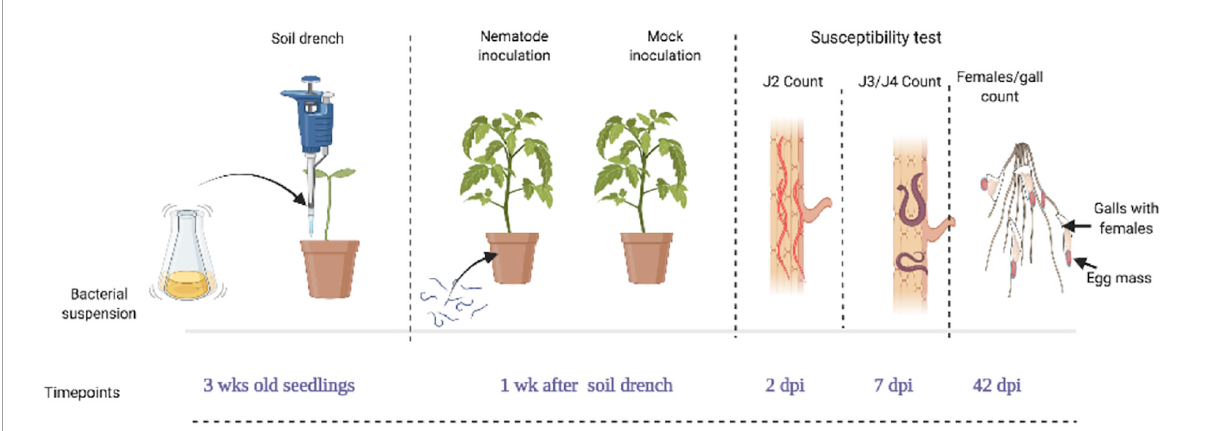
FIGURE1 Diagram showing the nematode parasitism experimental setup and timeline for susceptibility test on seedlings. Tomato seedlings of 3 weeks old were soil-drenched with bacterial suspension (BS) at doses of 30, 50, and 100%, while control plants were mock- and buffer-treated (Ctrl and BF) with the positive control, β -aminobutyric acid (BABA). Four weeks after germination (1 week after application of the bacteria), plants were inoculated with 300 M. incognita J2 per plant and were analyzed for the total number of galls and egg laying females (ELF) at 42 days post-inoculation (dpi), the number of J2 and J3/J4 stages at 2 and 7 dpi. This figure was created with www.BioRender.com.